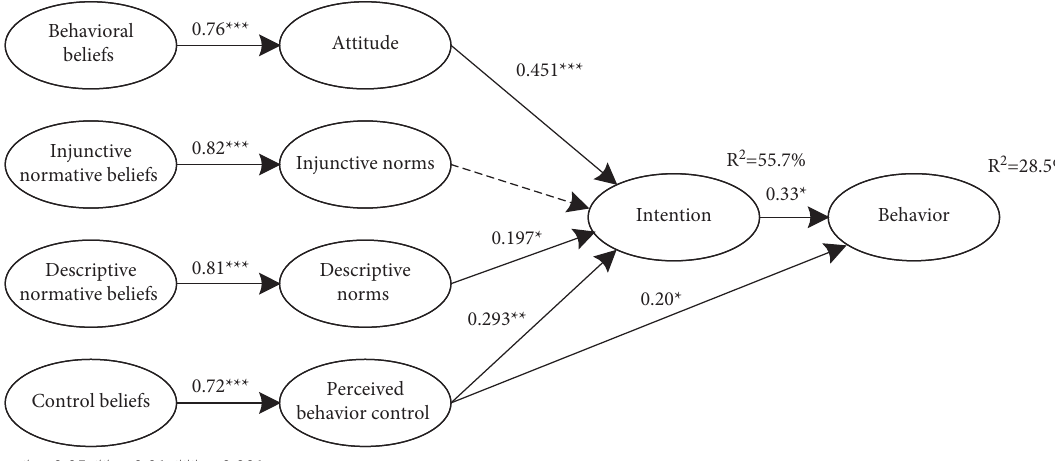
Figure 1: TPB model for e-bike couriers’ traffic violation